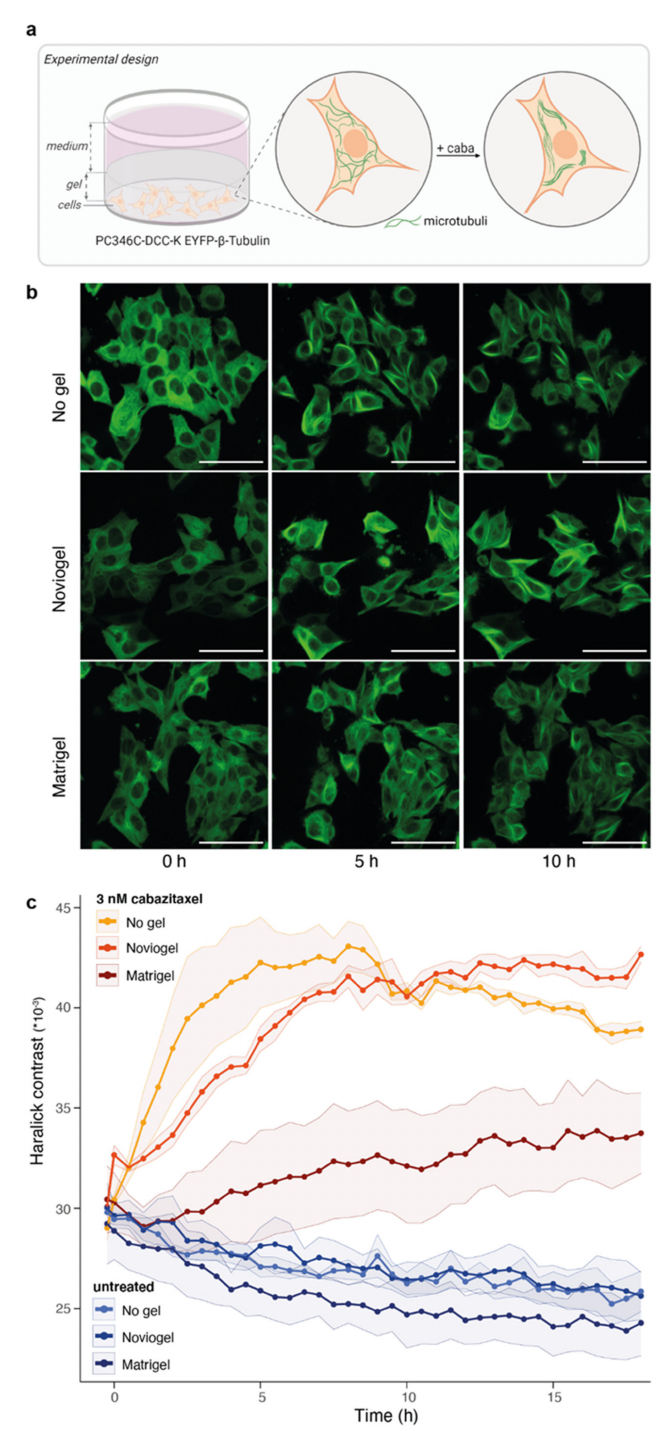
Figure 3. Impact of scaffolds on taxane-induced tubulin stabilization. ( a ) Schematic representation of experimental design. EYFP- β -Tubulin: enhanced green fluorescent protein labelled beta-tubulin; caba: cabazitaxel ( b ) Representative images